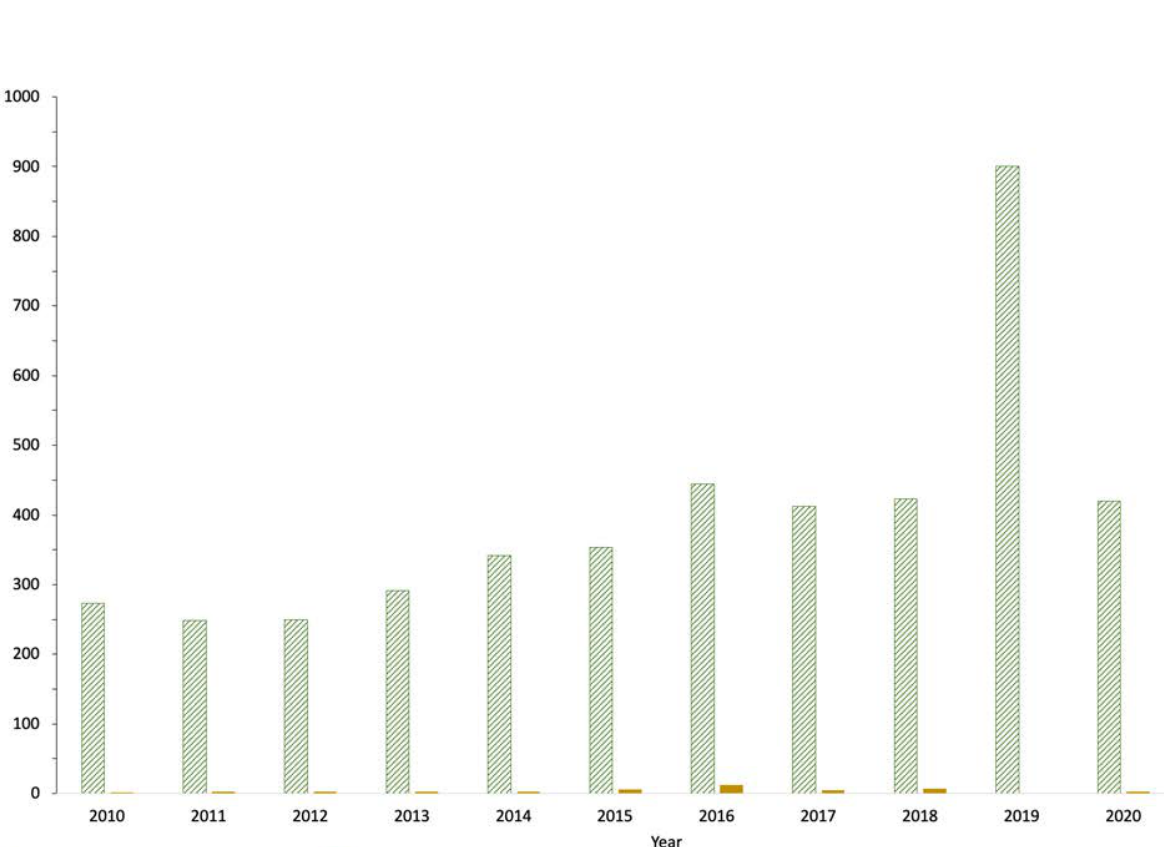
Figure 1. Results of Google Scholar online literature search using the following terms: ‘peatland rehabilitation’, ‘peatland rehabilitation+archaeology’, ‘peatland rehabilitation+palaeoecology’. Numbers of papers published in each year between 2010 and 2020 on peatland rehabilitation are shown in green and those on peatland rehabilitation which also include heritage, archaeology and/or palaeoecology are shown in